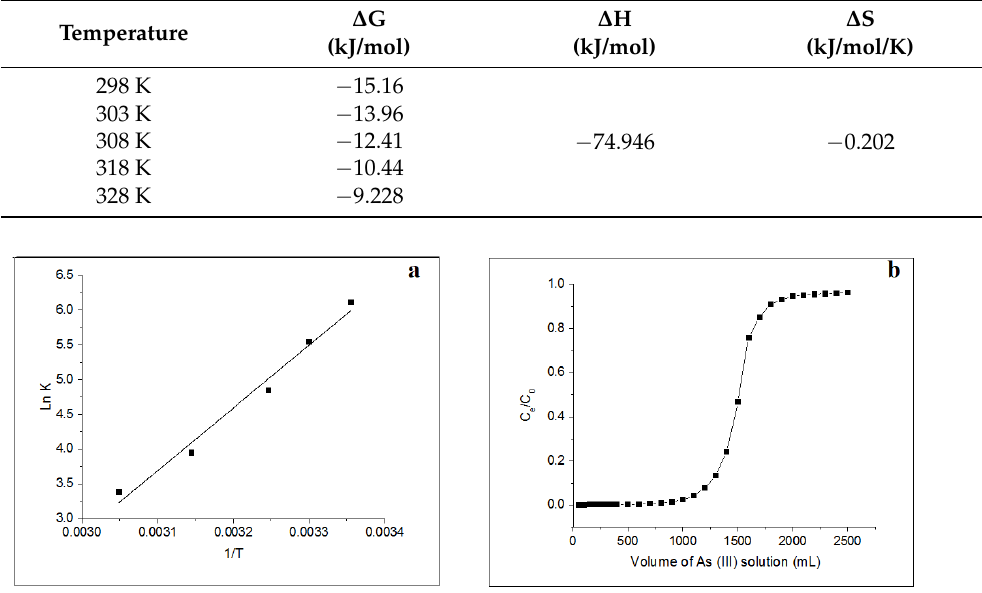
Figure 7. ( a ) Van ’ t Hoff Plot and ( b ) Column study-breakthrough curve. Figure 7. ( a ) Van’t Hoff Plot and ( b ) Column study-breakthrough Table 2. Thermodynamic parameters.